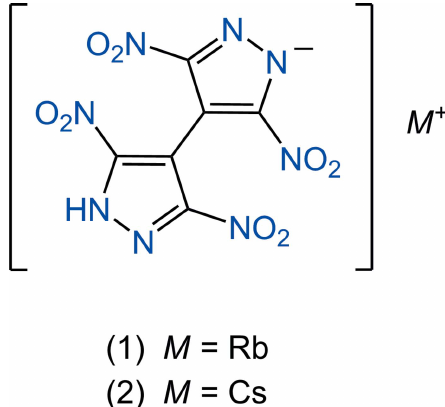
Table 2 Selected bond lengths (A˚ ) for ( 2